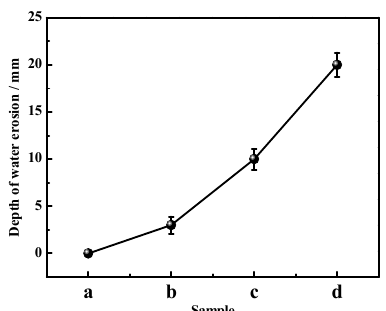
Figure 5. Water erosion depth of the MOC samples after different dry–wet cycles: (a) without dry–wet cycles; (b) one time; (c) two times; (d) three times.